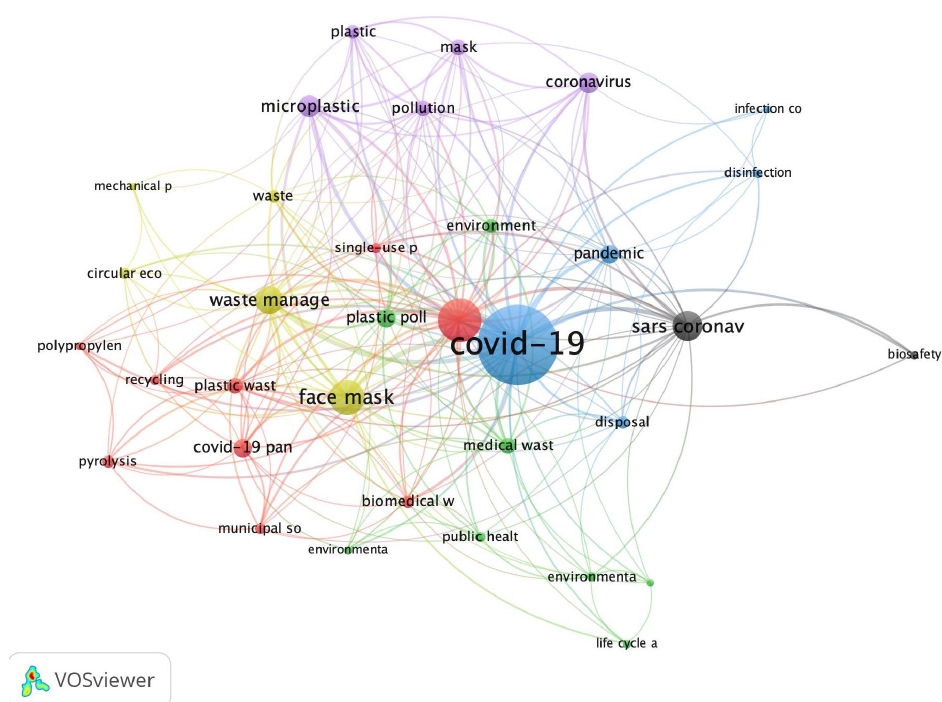
Figure 11. Network co-occurrences of author keywords’ visualization with a minimum of 5